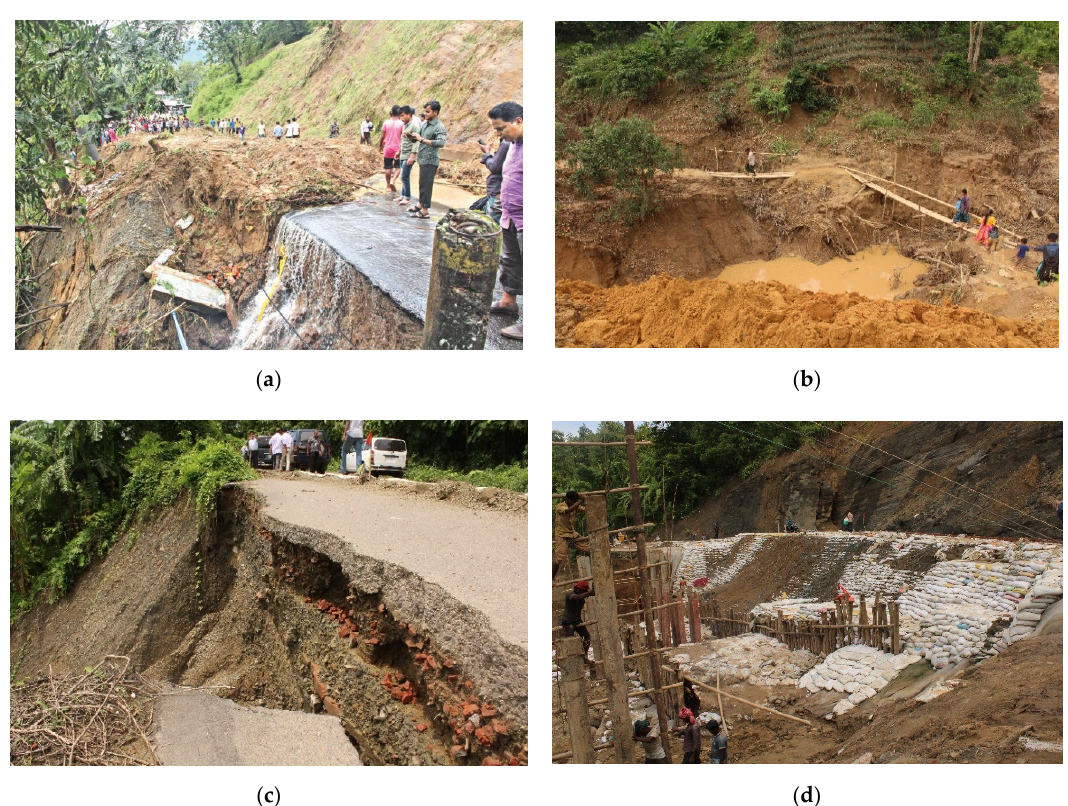
Figure 2. ( a ) Part of the Rangamati-Chattogram road collapsed at Manikchhari; ( b ) people had built a temporary solution after the local road had been damaged near the Rangamati-Khagrachari road; ( c ) heavily damaged Rangamati-Manikchari road; ( d ) temporary measures were taken on the Rangamati District road to reestablish the road network.